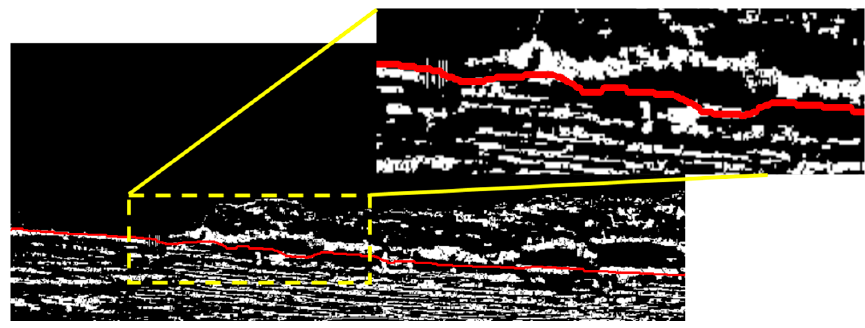
Figure 12. The result of the final segmentation.